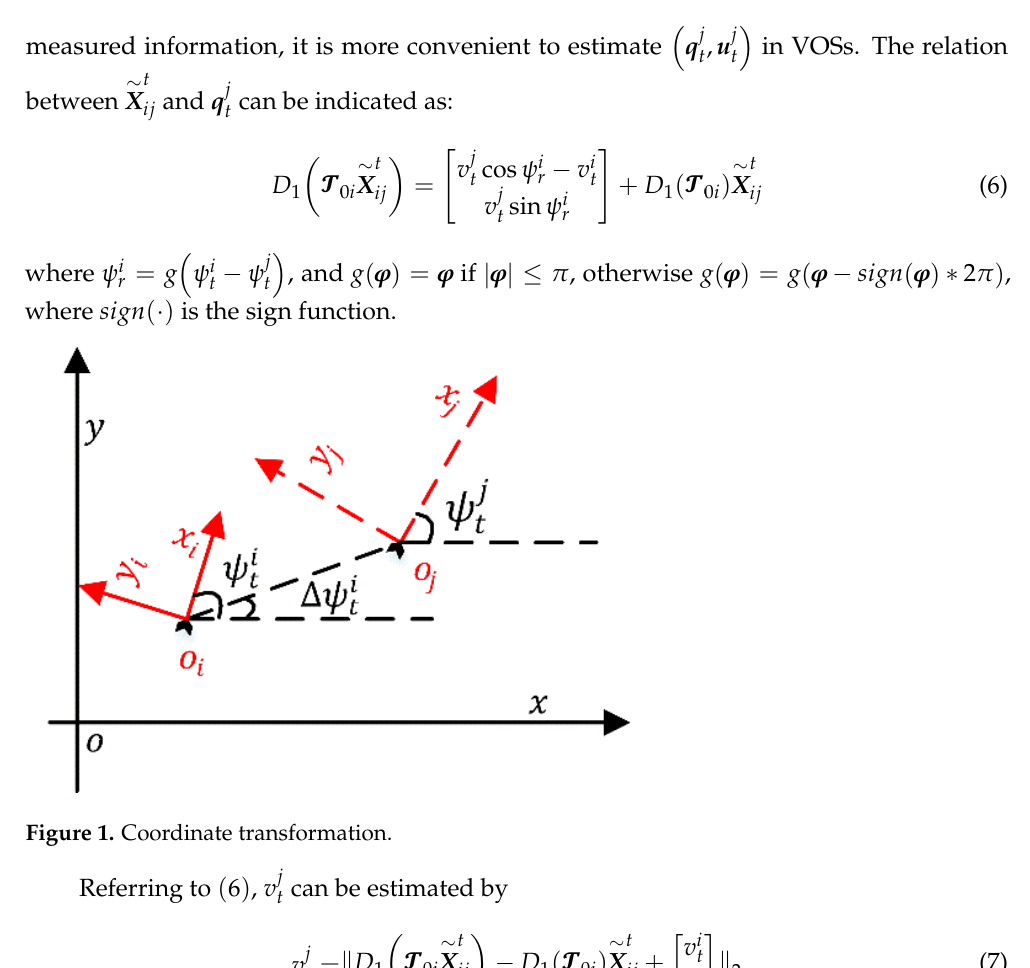
Figure 1. Coordinate transformation.